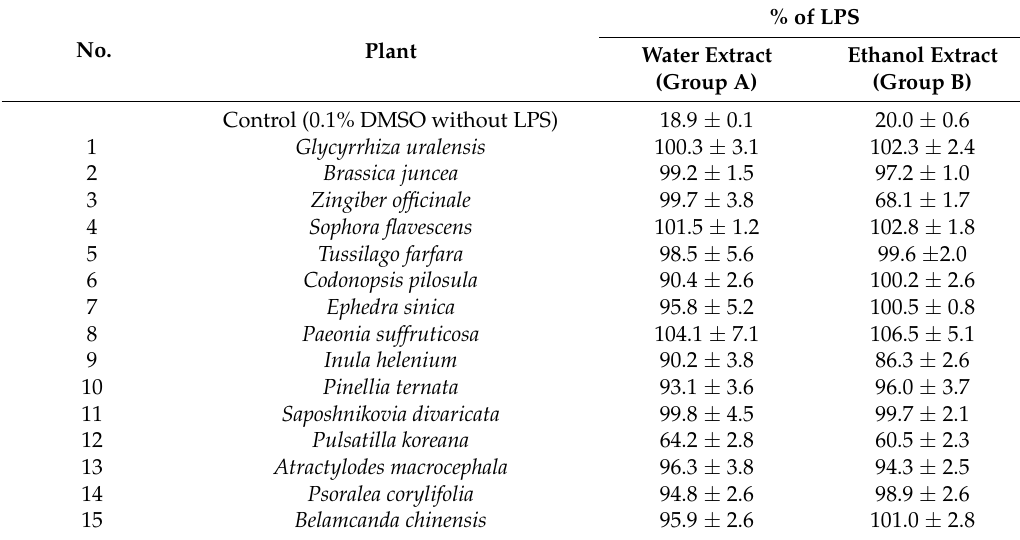
Table 1. NO assay results of single plant